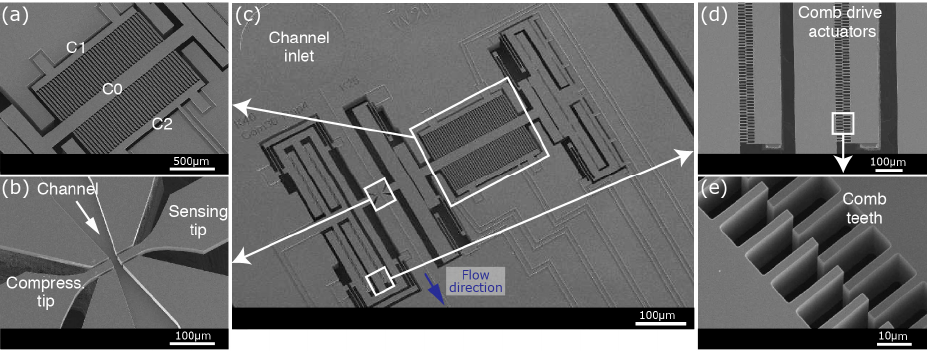
Figure 4. SEM images of the fabricated device: ( a ) Displacement sensor based on differential capacitors, ( b ) opposing tips accessing the handling area, ( c ) an overview of the device, ( d ) electrostatic comb drive actuators with ( e ) a close-up view. Table 1. Main parameters of device designs.